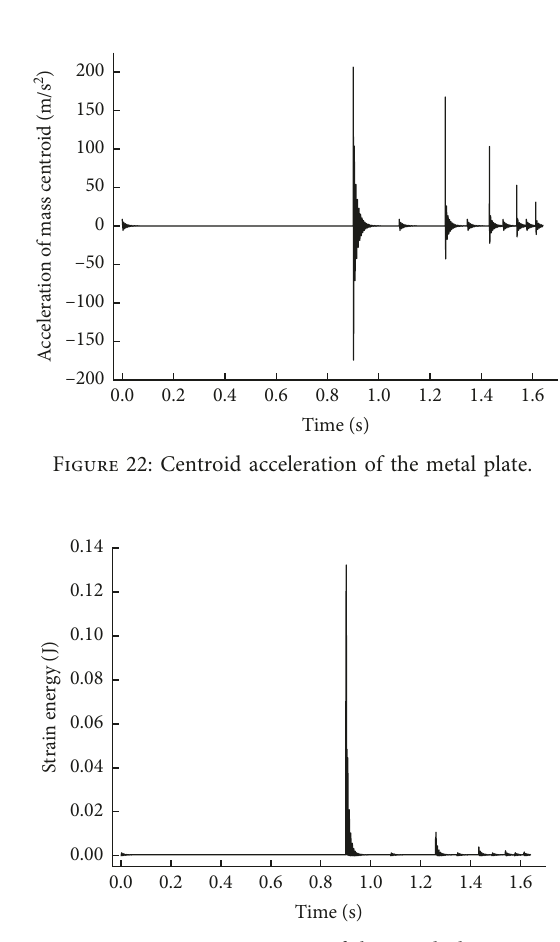
Figure 23: Strain energy of the metal